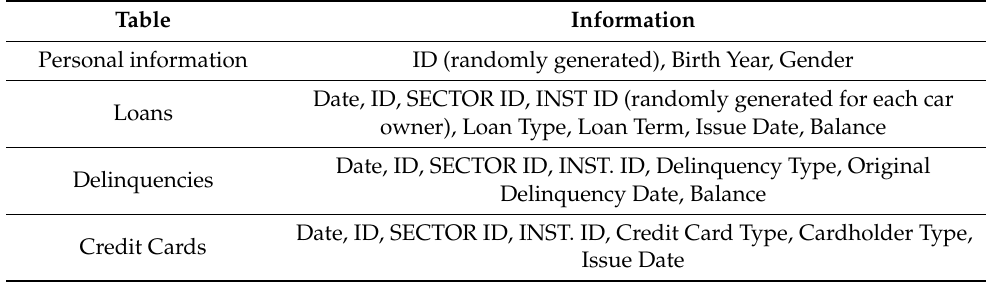
Table 1. Consumer Data Tables and columns. Table